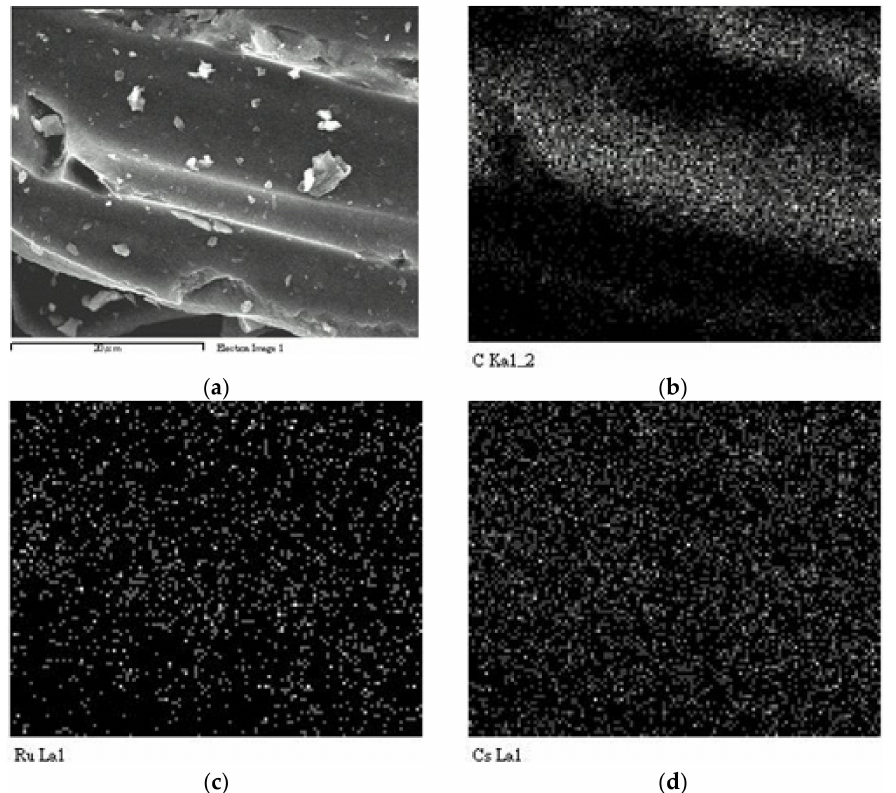
Figure 2. The SEM image and maps of elements for the overall molar ratio of Cs/Ru = 6, ( a ) SEM image, ( b ) map of element C, ( c ) map of element Ru, and ( d ) map of element